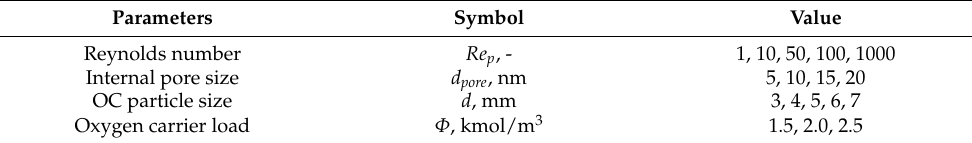
Table 3. The specified variable parameters setting with a single large OC particle.